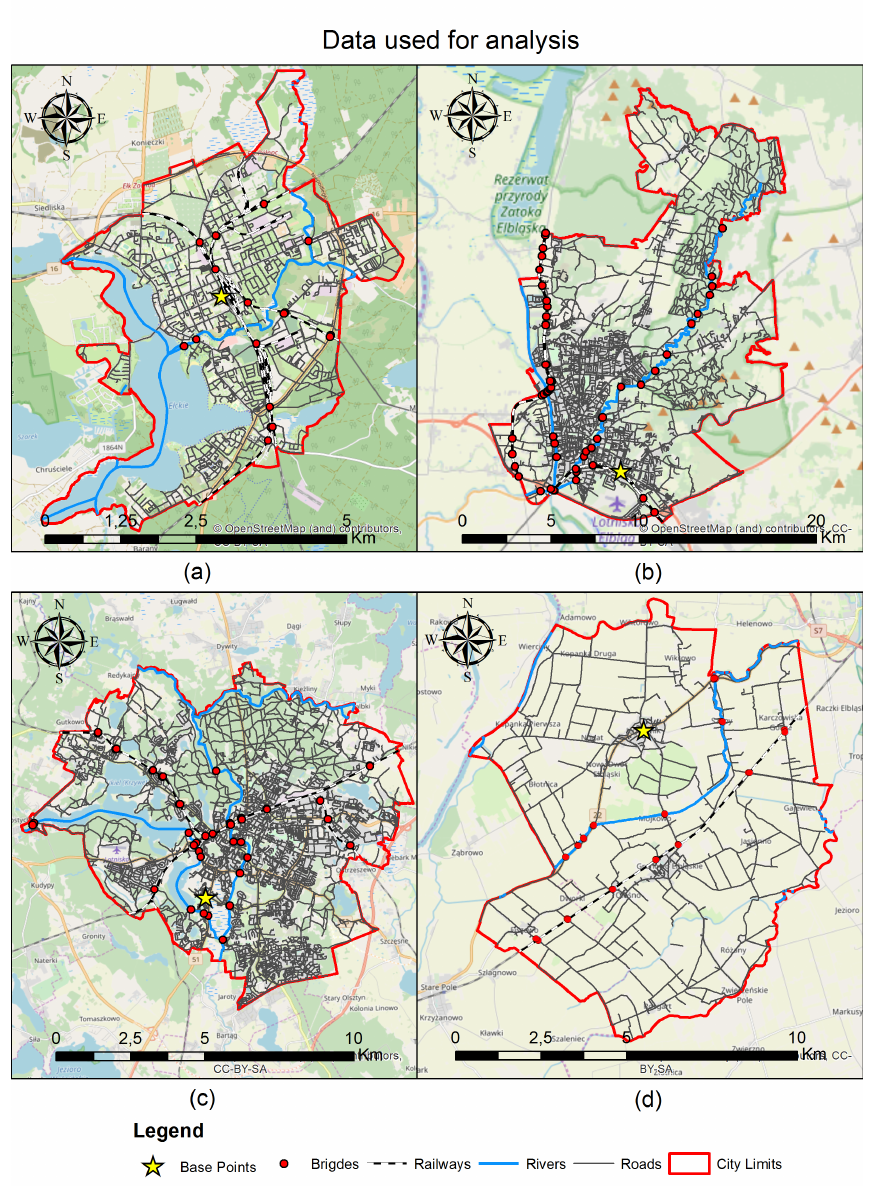
Figure 6. The analyzed objects with barriers (roads, rivers), bridges and base points: ( a ) Ełk; ( b ) Elbl ˛ag; ( c ) Olsztyn, ( d ) Gronowo Elbl